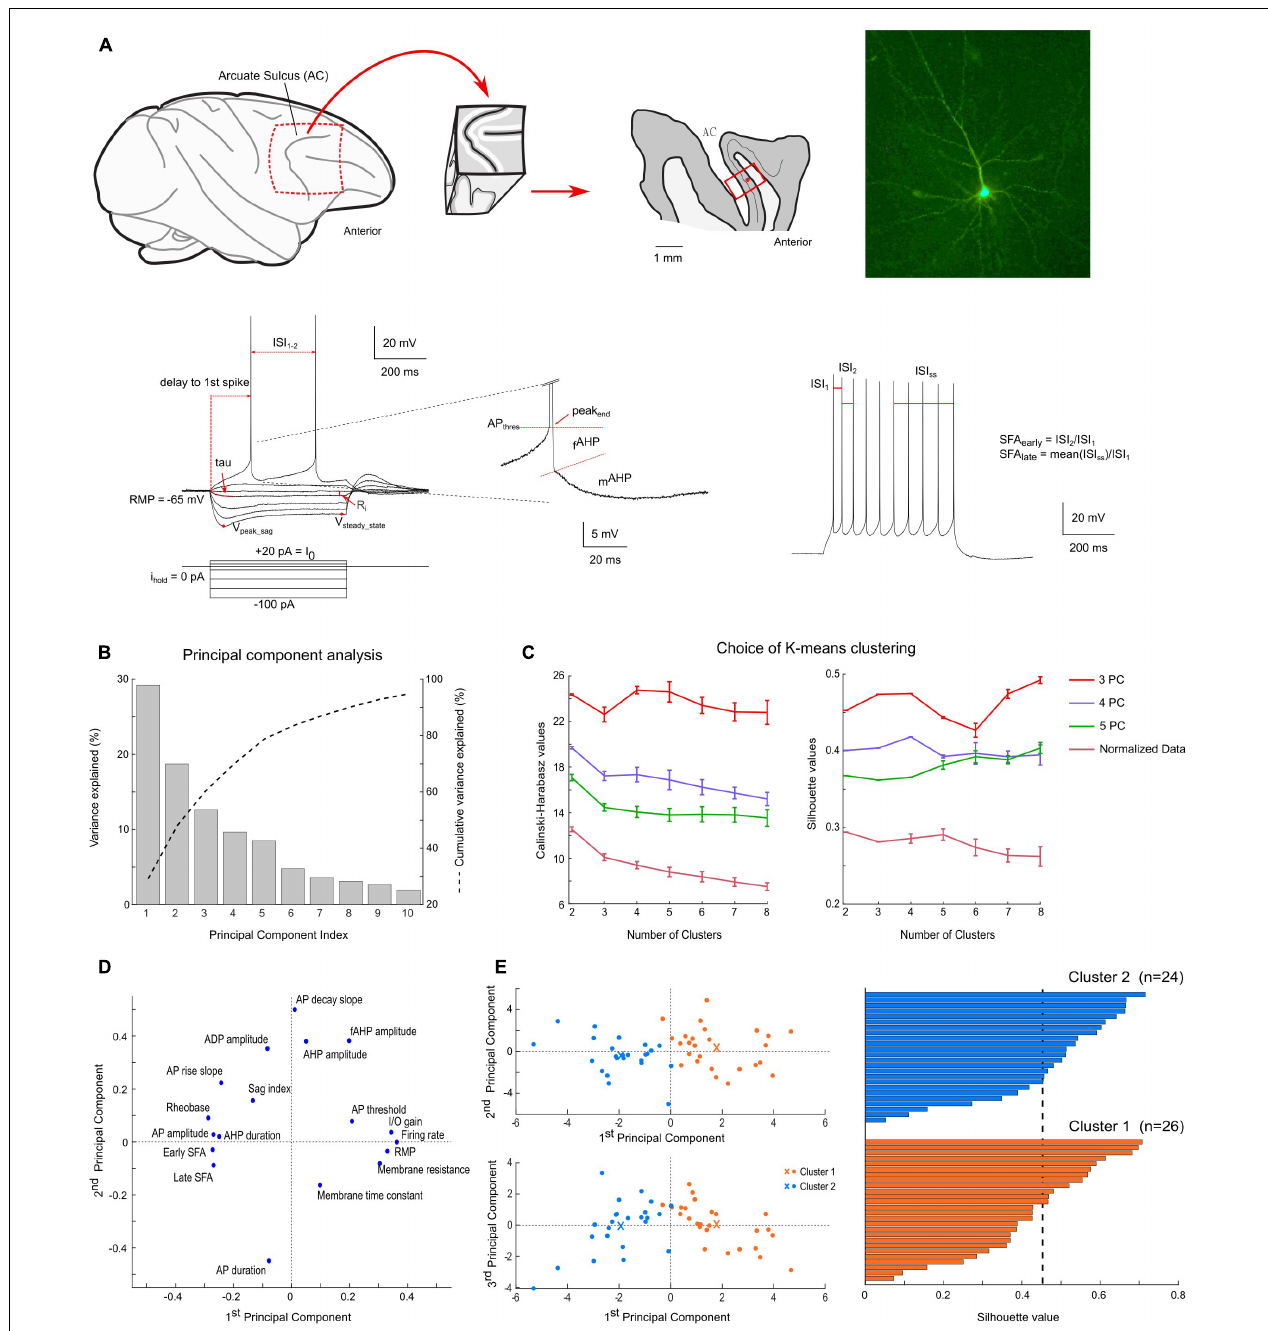
FIGURE 1 | Methodology and results of the clustering analysis. (A) Brain slice preparation; from left to right: sagittal view of the frontal cortex of macaque monkey (circle highlights the FEF localization, from which a biopsy is extracted), sagittal section through the FEF biopsy (layer 4 is indicated by a thin black line, the recording location is indicated by a red dot) and example of a recorded pyramidal neuron after fluorescent revelation of biocytin filling; Bottom: electrophysiological response of a pyramidal neuron to current step injections (left: up to rheobase; right: first train of at least 9 spikes; center: close-up on a spike AHP). Parameters used for analysis (in red) are further described in section “Materials and Methods.” (B) Percentage of variance explained by each principal component of the principal component analysis. k -means clustering was performed on up to the first five principal components, which explained more than 80% of the total variance. (C) Variation of the Calinski-Harabasz index and average silhouette values as a function of the number of clusters and PCA results. These two indices were used to define the optimal number of clusters in the data. (D) Projection of the 18 electrophysiological parameters used for clustering on the first two principal component axes. (E) Results of the k -means clustering algorithm applied to the first three principal components with 2 clusters ( n = 26 cells for cluster 1, in orange; and n = 24 for cluster 2, in blue). As visible on the projection plane (left), the first principal component contributes the most to the discrimination between the two clusters. The centroids of the clusters are indicated by orange and blue crosses. The silhouette scores (right) indicate a good level of compactness of each cluster.